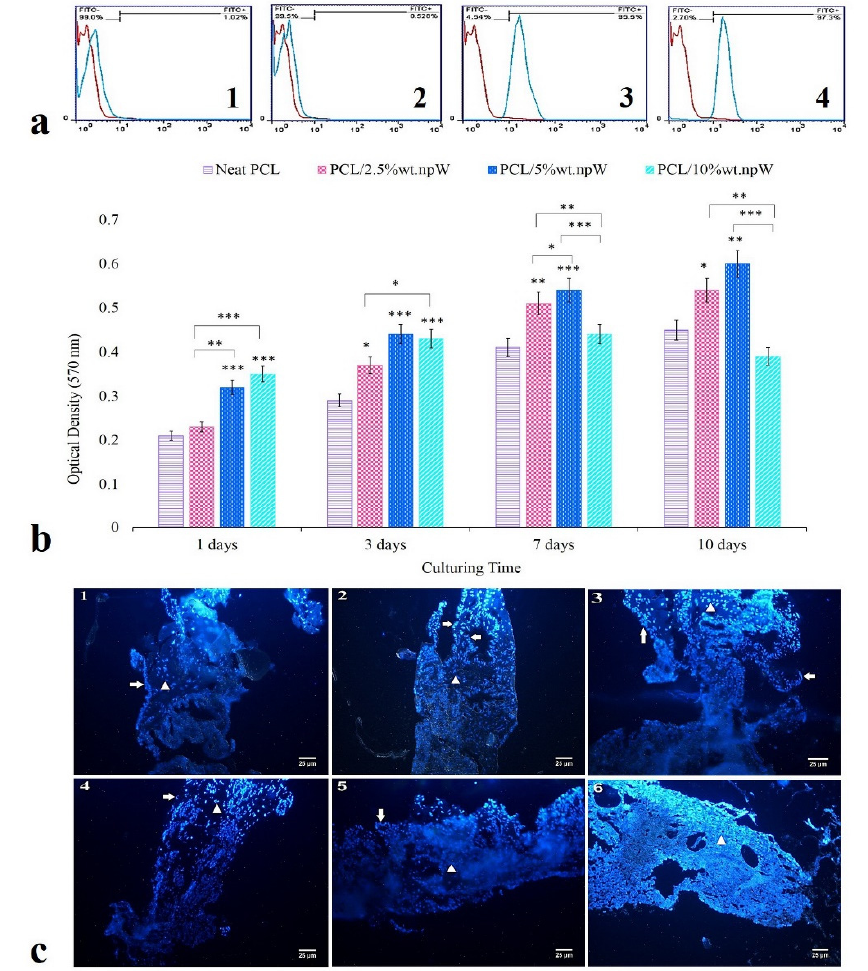
Figure 4. Cytocompatibility analyses of PCL/npW versus neat PCL. ( a1 – a4 ) Characterization of rBMS cells using alpha-SMA, CD44, CD34, and CD45 markers by flow cytometry. ( b ) Viability of rBMSCs on scaffolds at 1, 3, 7, and 10 days of cell culture by MTT assay ( c1 – c6 ). Distribution of rBMSCs in porous PCL/5% wt. npW scaffolds visualized using histological cross-sectioning and DAPI nucleus staining, on 3, 5, 7, 9, 11, 13 days after culture, respectively; the arrows and arrow- heads represent the rBMSCs on the surface and within the scaffold, respectively. Data are shown as mean ± SD. * p < 0.05, ** p < 0.01, *** p < 0.001 compared to neat PCL. Images obtained by SEM microscopy showed the presence of cells on the PCL/5 wt. npW scaffold surface, as well as within the pores (Figure 5a).